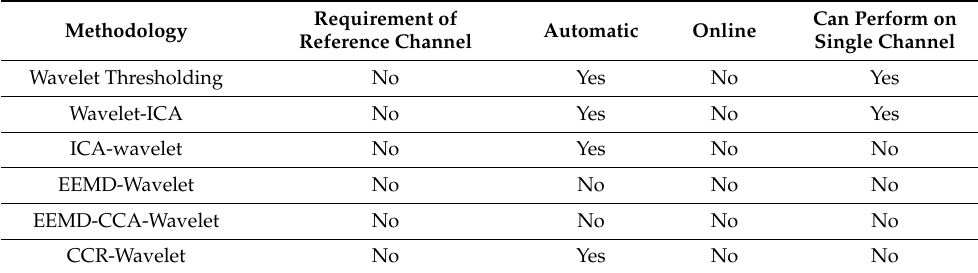
Table 1. Comparison of wavelet-based EEG denoising